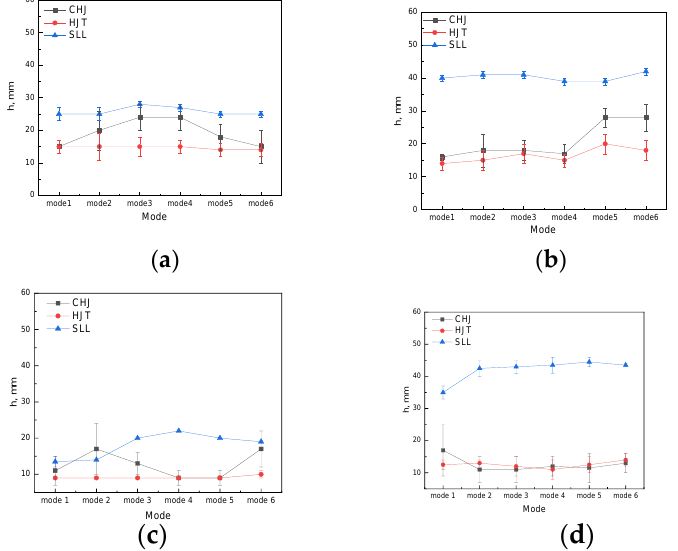
Figure 10. Hydraulic jump height of different laying modes in three hydraulic jump forms (( a ) 0.8 m/min, with solidification ( b ) 2.4 m/min, with solidification ( c ) 0.8 m/min, without solidification ( d ) 2.4 m/min, without solidification).